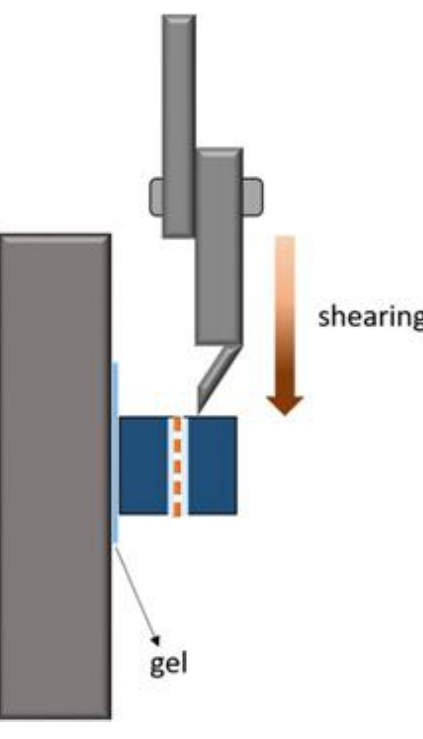
Figure 6. Illustration of the shear testing.